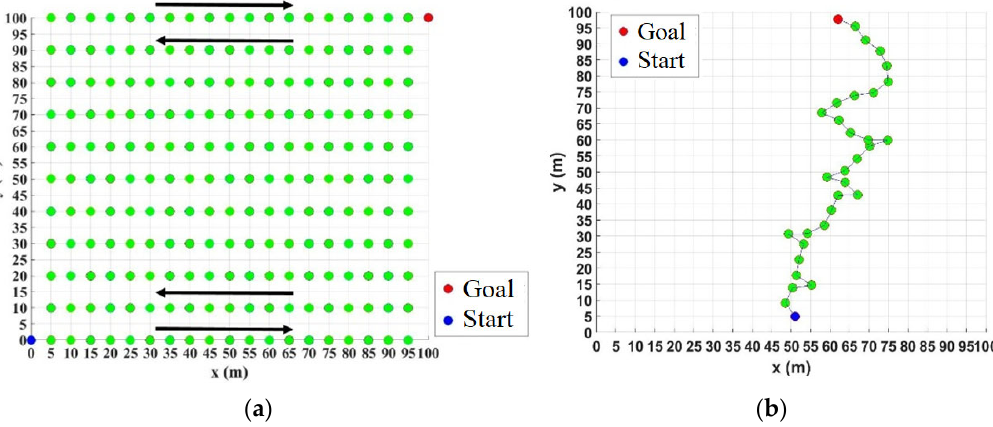
Figure 7. Moving tracks of target points for the target tracking method: ( a ) snake track; ( b ) random track.